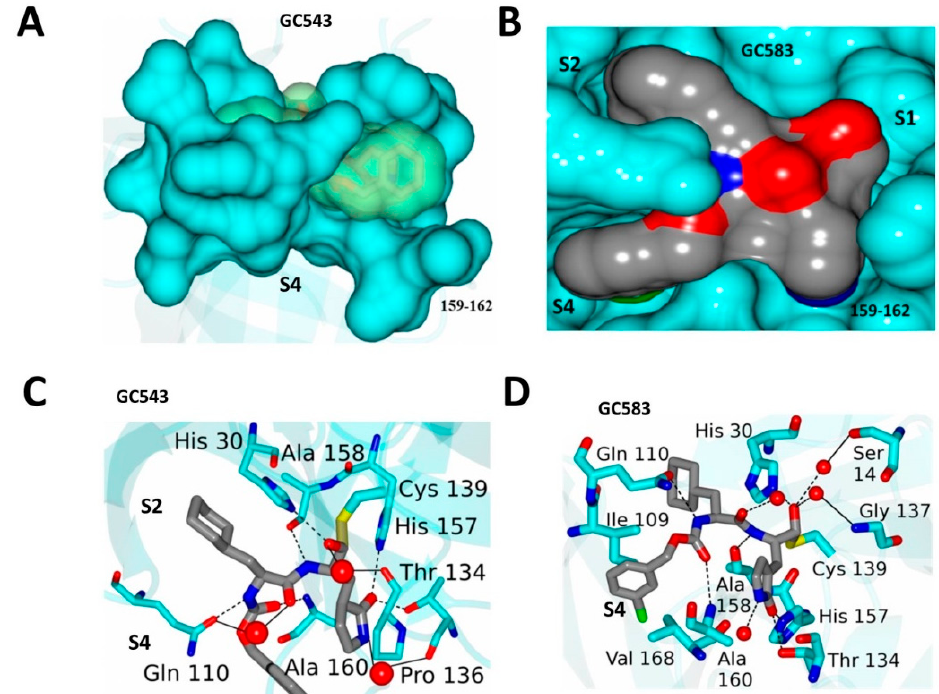
Figure 9. X-ray crystal structure of NV 3CL Pro and GC543 ( A , C , PDB: 4XBC) and GC583 ( B , D , PDB: 4XBB). The structures revealed that increased potency is correlated to interactions between the S 4 subsite and the cap residue. The m -Cl benzyl group in the cap allows for interactions with hydrophobic residues in S 4 .